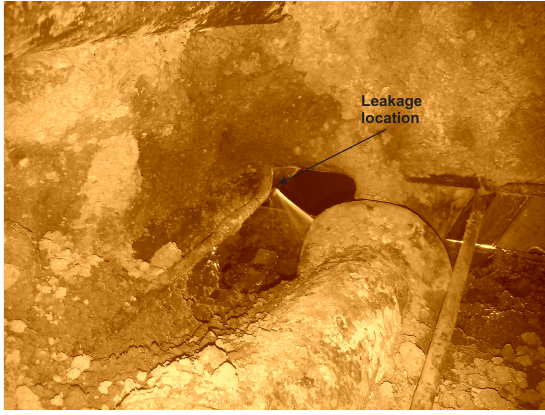
Figure 7. Leakage location, pipes damaged on 13th January 2014.